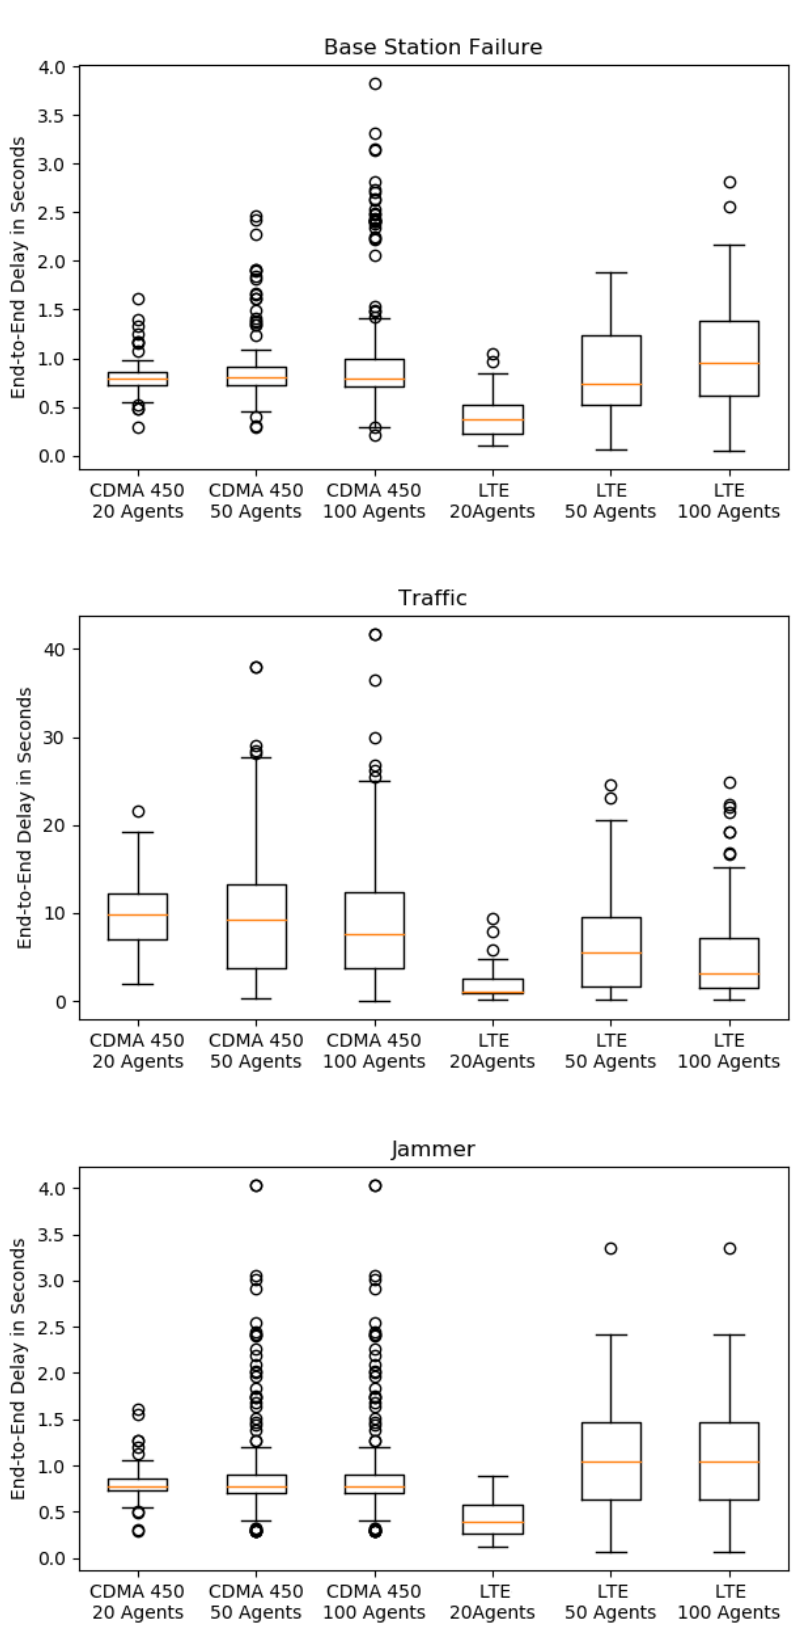
Figure 7. End-to-End latencies of different ICT scenarios determined via